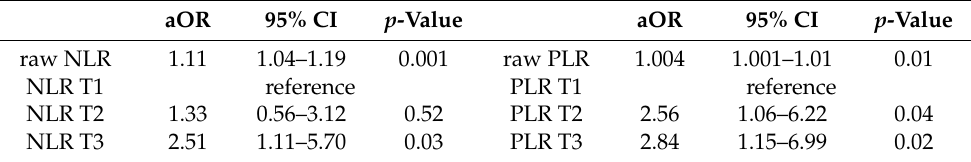
Table 3. Logistic regression analysis showing effect of NLR and PLR on unsuccessful